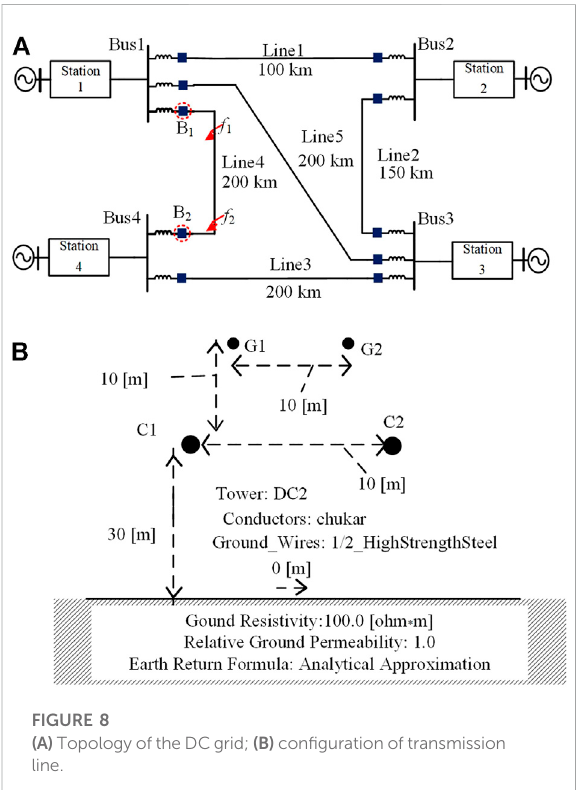
FIGURE 8 (A) Topology oftheDCgrid; (B) con fi gurationoftransmission line.